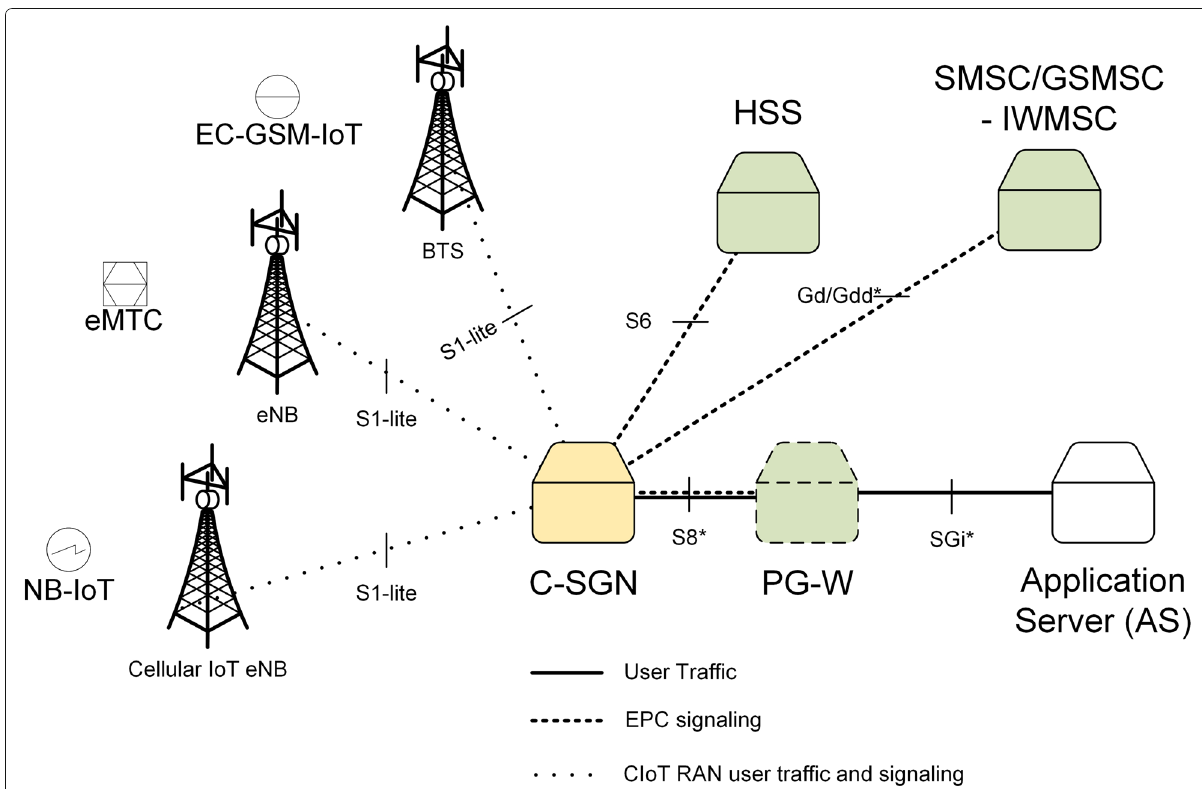
Fig. 14 The general CIoT architecture. The S-GSN communicates user and signaling traffic over the S1-lite interface with the CIoT radio access network. The S8*, SGi*, and Gd/Gdd* interfaces indicate CIoT-specific session management per the IoT application requirements defined in the AS.